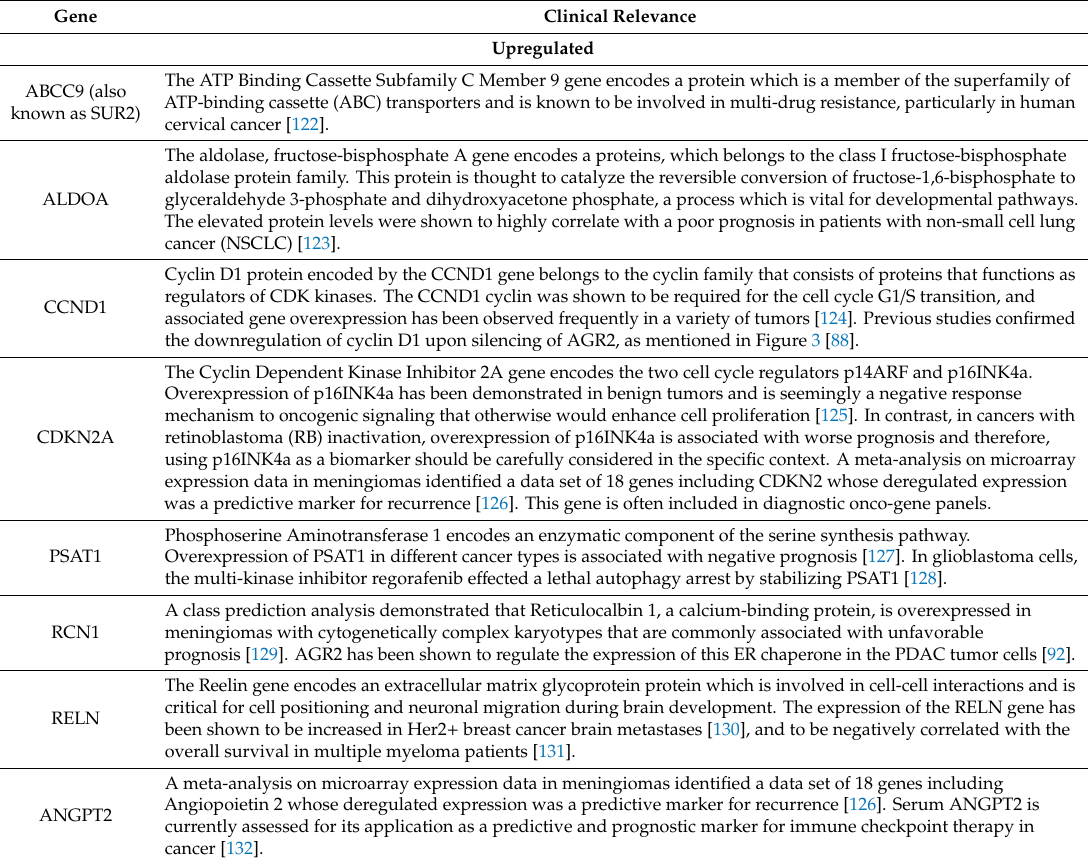
Table 3. Clinically relevant deregulated cancer-related genes identified in AGR2 high meningiomas. Gene Clinical Relevance